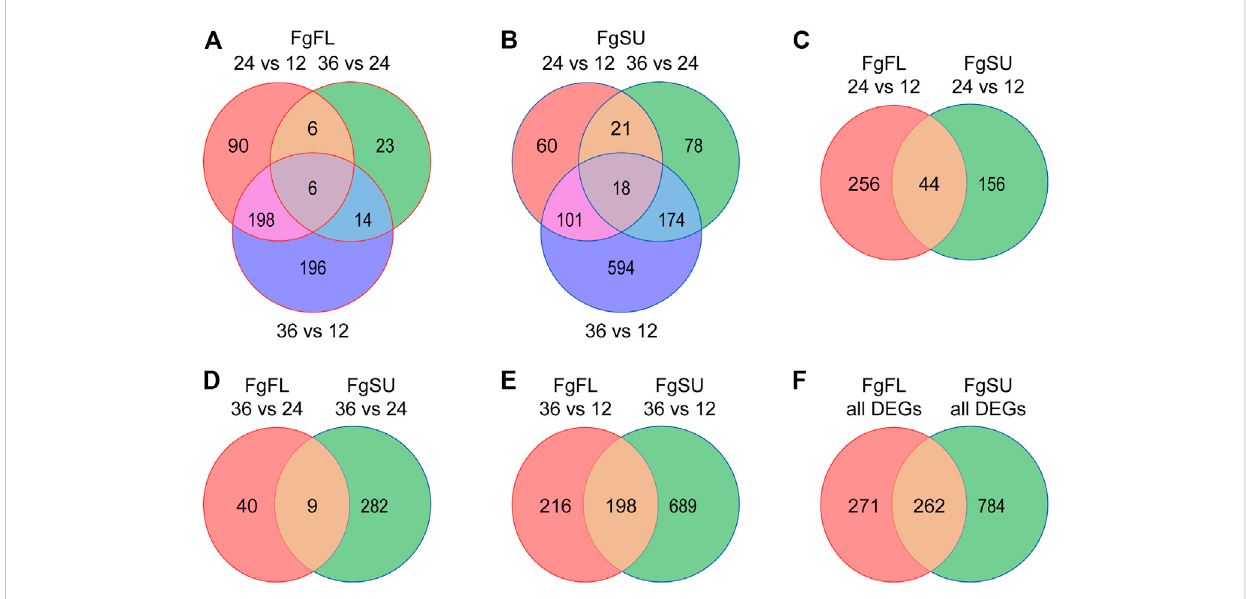
FIGURE 2 Dynamic distribution of Fusarium graminearum DEGs in hosts. (A) and (B) Venn diagrams showing the dynamic distribution of differentially expressed Fusarium graminearum genes during infection of the wheat varieties Fielder (A) and Sumai3 (B) . All of the DEGs were identi fi ed from the three comparisons. (C – E) . Venn diagrams showing the distribution of Fusarium graminearum genes differentially expressed between Fielder and Sumai3. (F) Venn diagram of the distribution of all differentially expressed Fusarium graminearum genes identi fi ed in Fielder and Sumai3 within 36